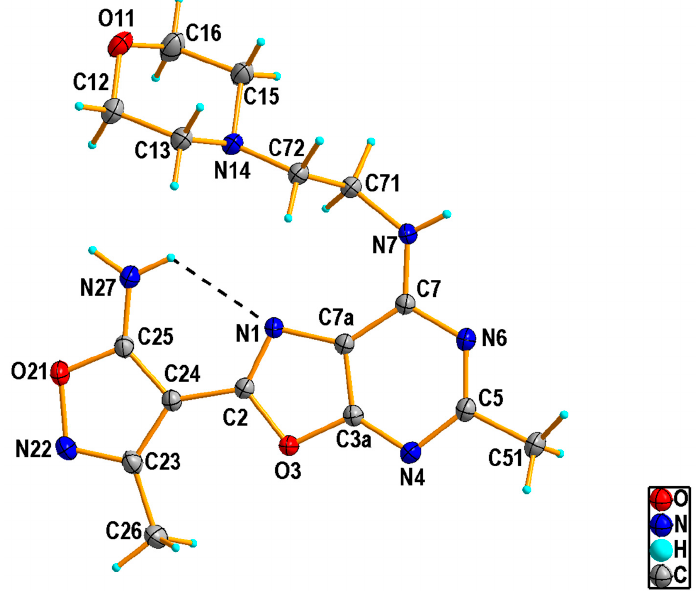
Figure 2. X-ray crystal structure of 5h , with atom-numbering scheme. Displacement ellipsoids are drawn at the 30% probability level. H atoms are shown as small spheres of arbitrary radii.